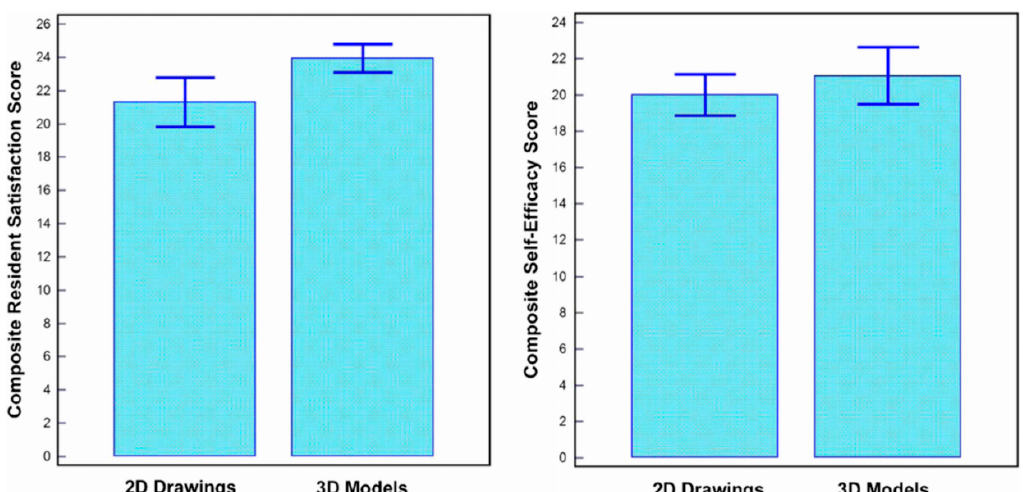
Figure 5. Impact of 3D printed heart models on medical education. Improvement was found in residents’ knowledge on congenital heart disease with use of 3D printed models when compared to 2D images. A statistically significant difference was noticed in satisfaction ratings in the group having 3D printed heart models when compared to the control group ( p = 0.03). While residents in the 3D printed model group had higher self-efficacy scores, this did not reach significant difference compared to the control group using 2D images/drawings ( p = 0.39). Reprinted with permission under the open access from Loke et al. [22].